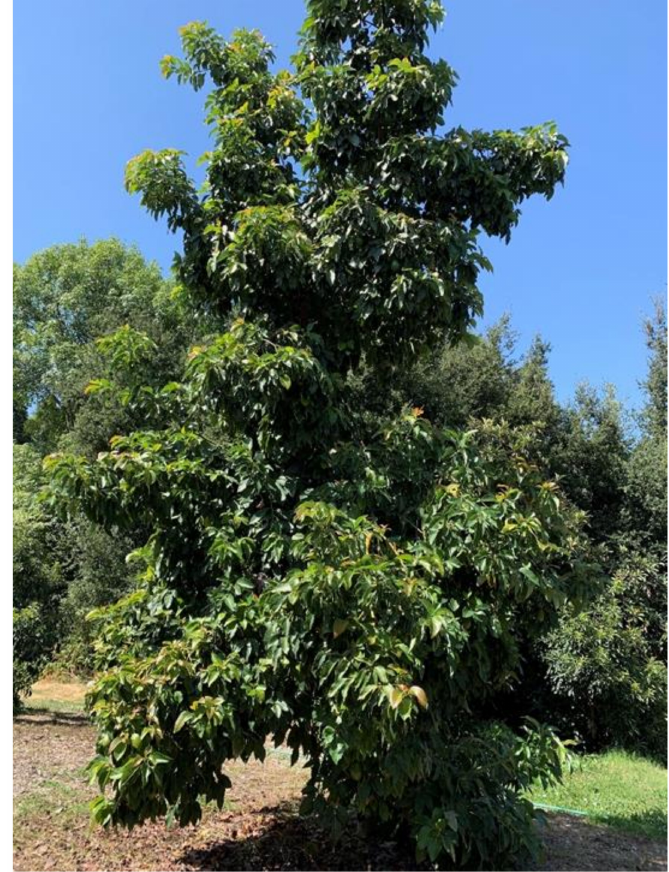
Figure 1. One of the 56 avocado accessions being maintained in The Huntington Botanical Gardens [in San Marino, California USA] living germplasm